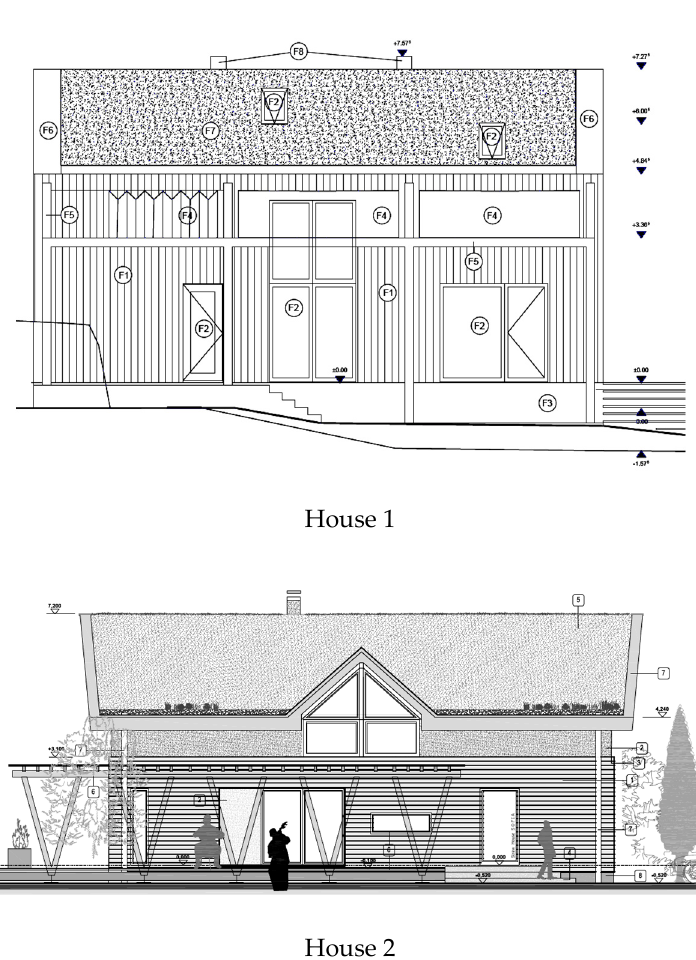
Figure 1. Views of family